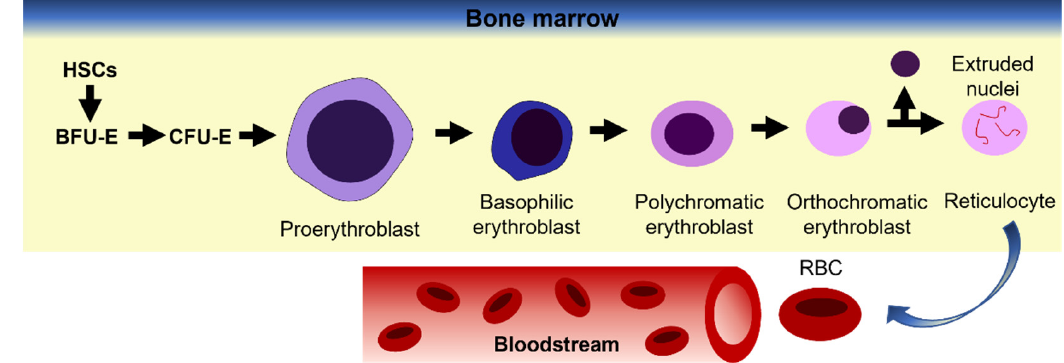
Figure 3. Erythropoiesis model. Hemopoietic stem cells (HSC) resident in the bone marrow proliferate and differentiate into burst-forming units (BFU-E) which further differentiate into highly proliferative colony forming units (CFU-E). Further differentiation gives rise to the earliest erythroblast progenitors, proerythroblasts. Maturation of erythroid progenitors is marked by changes in cell size, hemoglobinization, increased chromatin condensation and finally enucleation. The resultant cell is a reticulocyte which is released into the circulation to complete the final stage of maturation into an erythrocyte. Adapted from Shah, Huang and Cheng